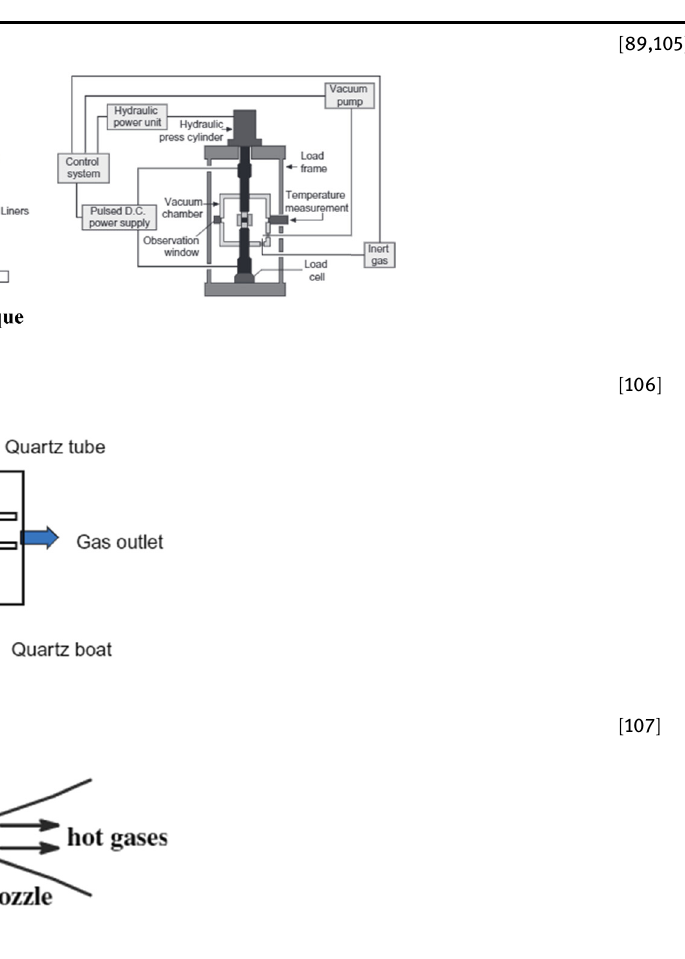
Table 9: The schematics of the manufacturing processes of CMNCs. The process schematics, which are not included are either chemical reactions or do not have any process